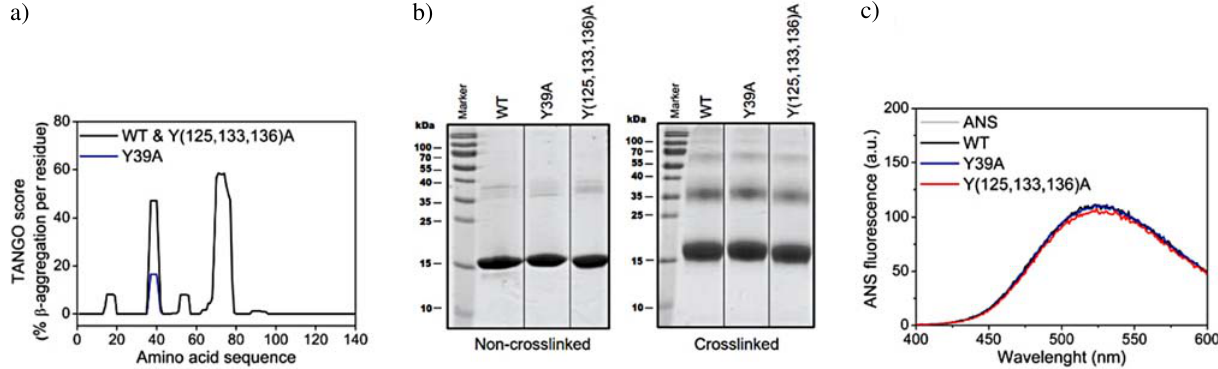
Figure 2. Characterization of the initial state of WT α -synuclein and its mutants. a) In silico prediction of β -aggregating regions using the TANGO algorithm. b) Oligomerization was analysed by SDS-PAGE of non-crosslinked and 2.5 % glutaraldehyde chemically crosslinked protein samples. c) Exposure of hydrophobic regions was analyzed by ANS